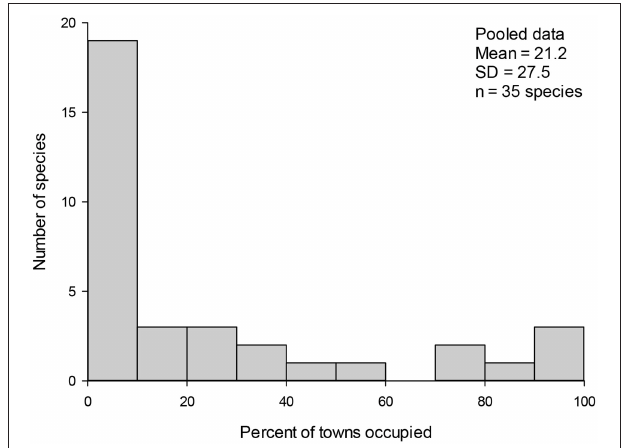
FIGURE 1 | Number of urban wintering bird species ( n = 35) in relation to the proportion of the study sites occupied in pooled data (%) in Finland. The proportion of sites occupied was divided to 10 equal size classes. The leftmost class represents satellite species, and the rightmost class represents the core species. Mean number of sites occupied and standard deviation (SD) of regional occupancy as well as the number of species ( n ) detected in three winters in 29 towns in Finland. Note that there were n = 87 study sites during three winters all together.